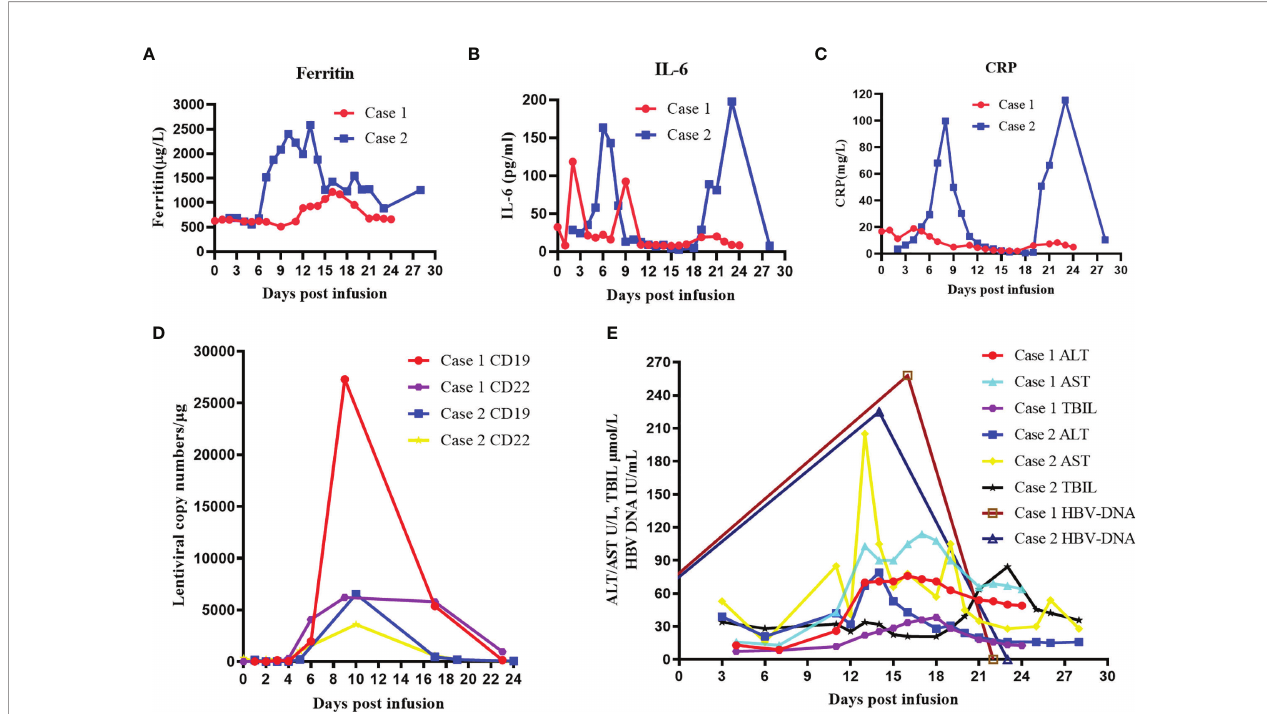
FIGURE 2 | Clinical evolutions after infusion of anti-CD19 and anti-CD22 CAR T-cell cocktail in patients. (A) Levels of serum ferritin after CAR T-cell infusion. (B) Levels of IL-6 after CAR T-cell infusion. (C) Levels of serum CRP after CAR T-cell infusion. (D) Lentiviral copy numbers after CAR T-cell infusion. (E) Dynamic changes in ALT, AST, TBIL, and HBV DNA levels after CAR T-cell infusion. CAR, chimeric antigen receptor; IL-6, interleukin-6; CRP, C-reactive protein; ALT, alanine transaminase; AST, aspartate transaminase; TBIL, total